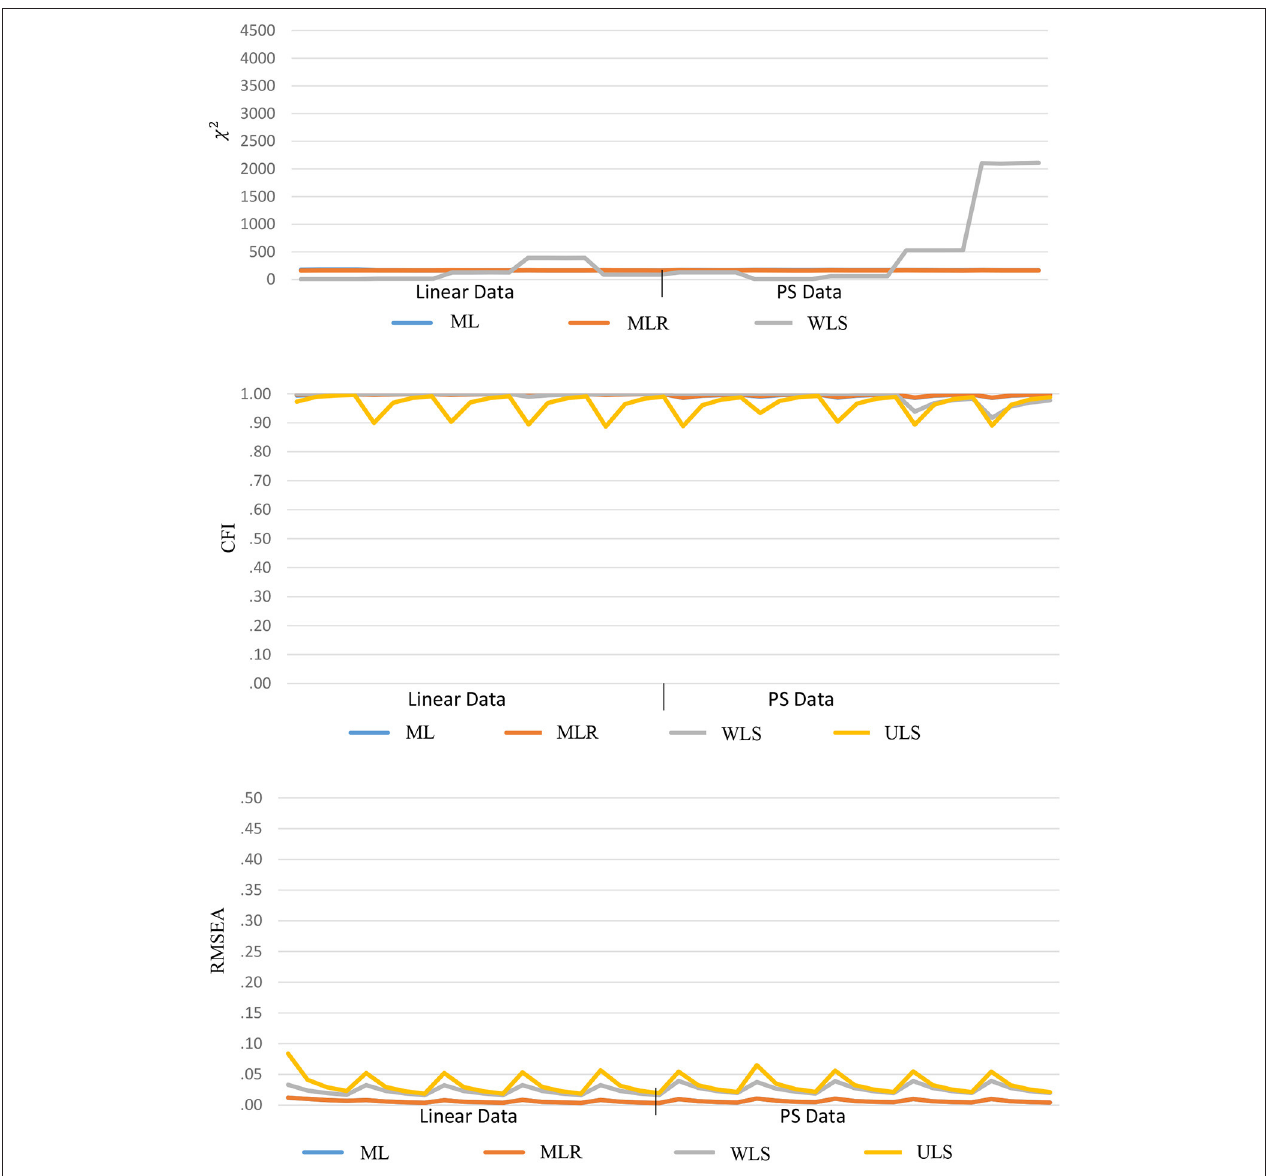
FIGURE 6 | Goodness-of-fit indices based on linear estimators across 40